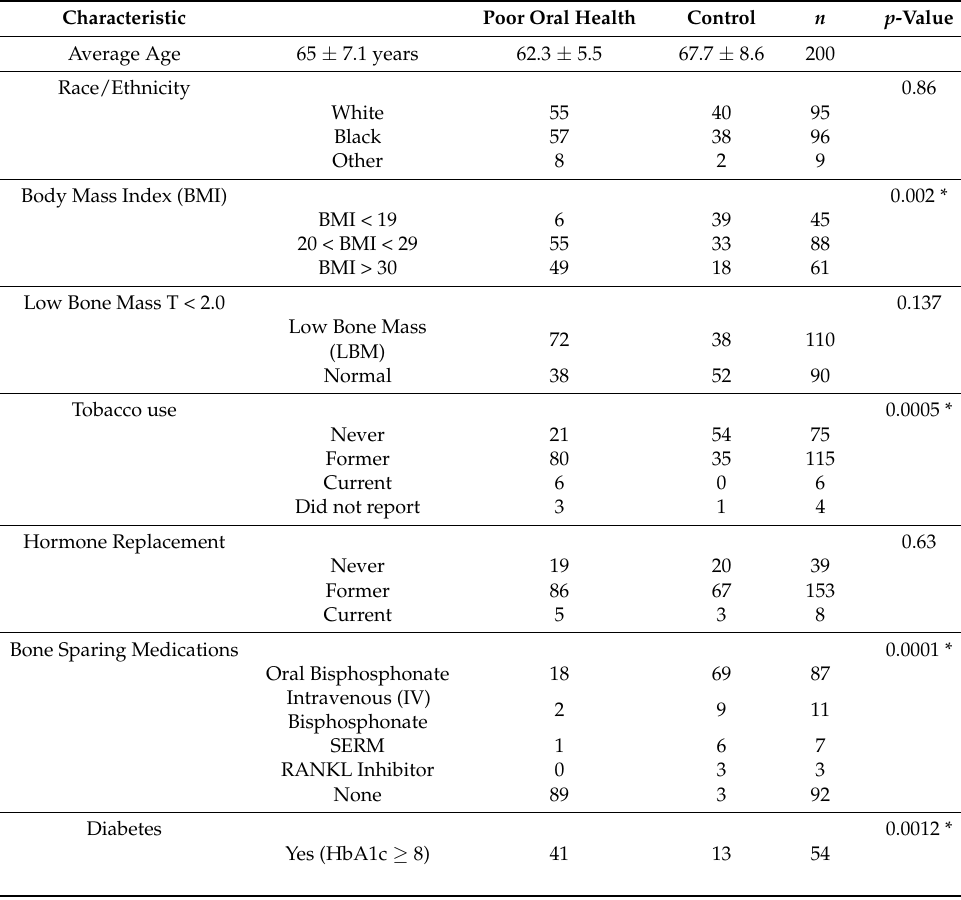
Table 3. Demographics divided according to poor oral health and control.